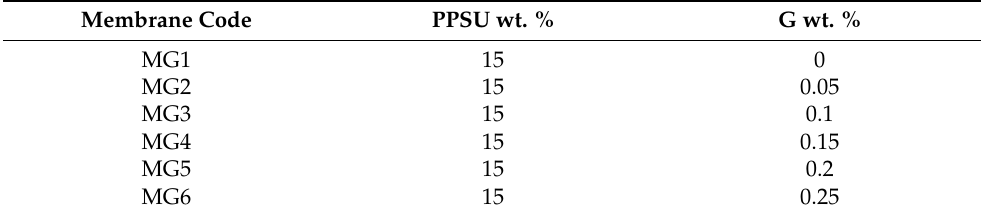
Table 1. Composition of the nanocomposite